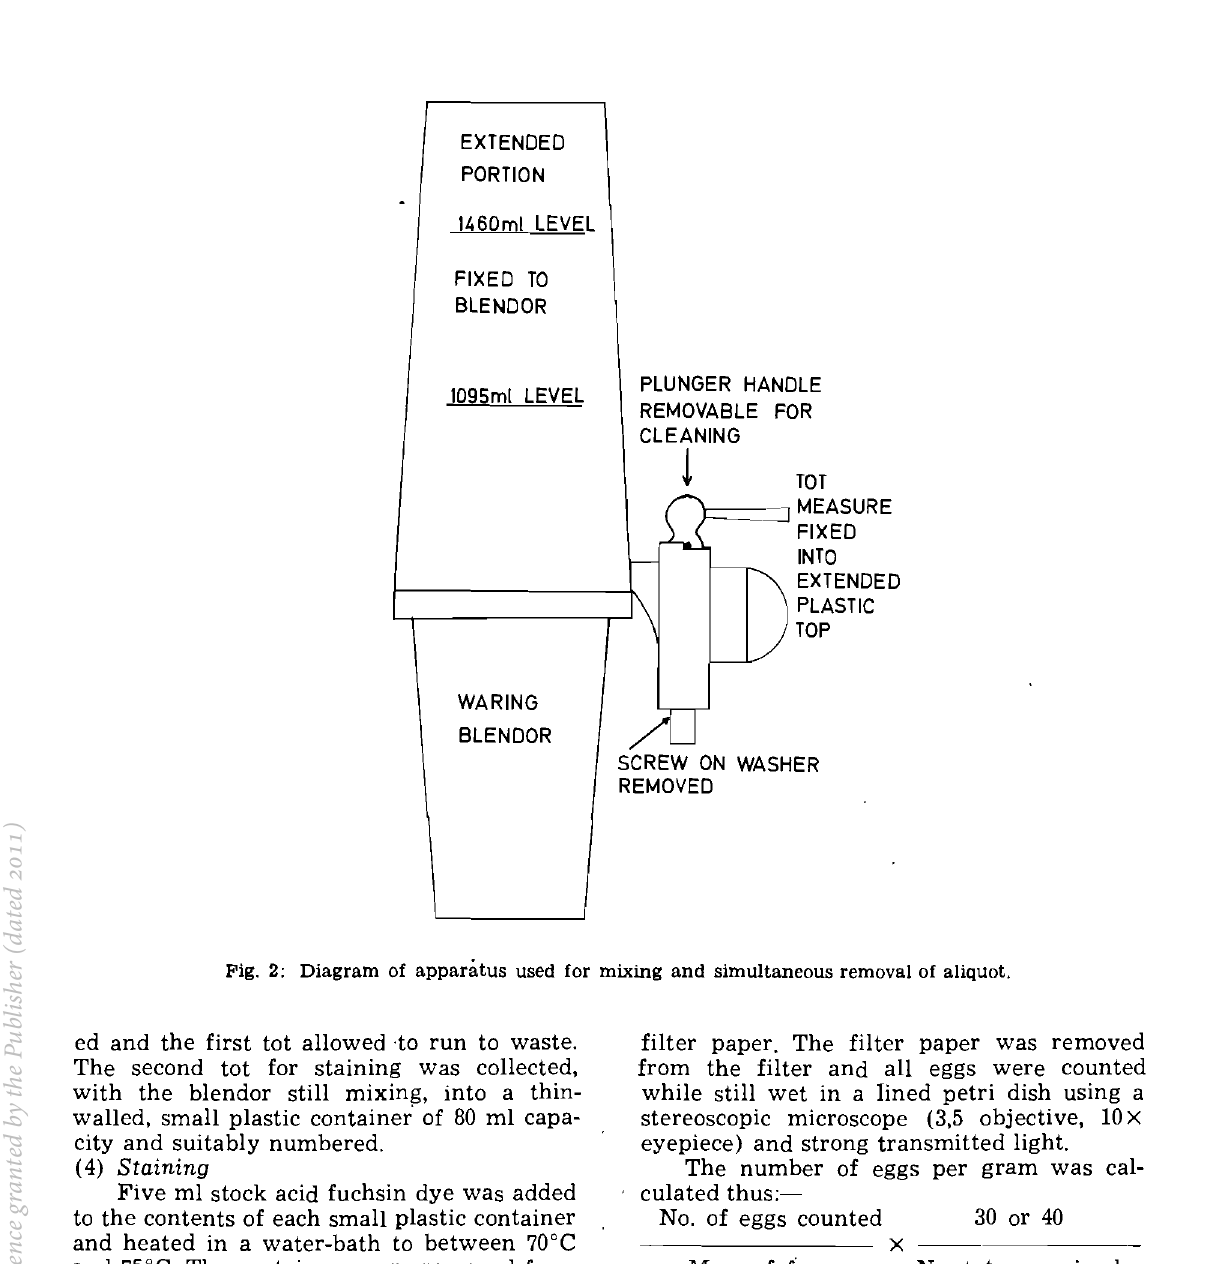
Fig. 2: Diagram of apparatus used for mixing and simultaneous removal of aliquot. ed and the first tot allowed -to run to